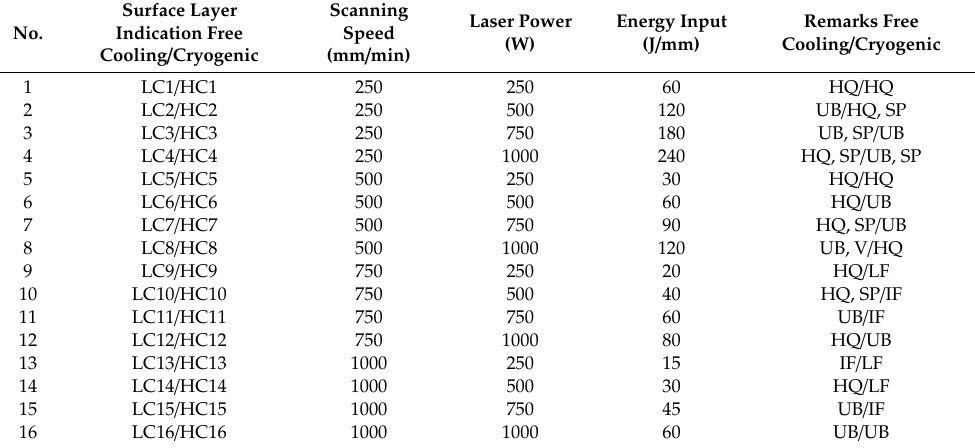
Table 3. Parameters of laser deposition of experimental Fe-based metallic powder at free cooling conditions (conventional laser cladding) and forced cooling by liquid nitrogen bath under cryogenic conditions (hybrid laser deposition process), as shown in Figure 3.